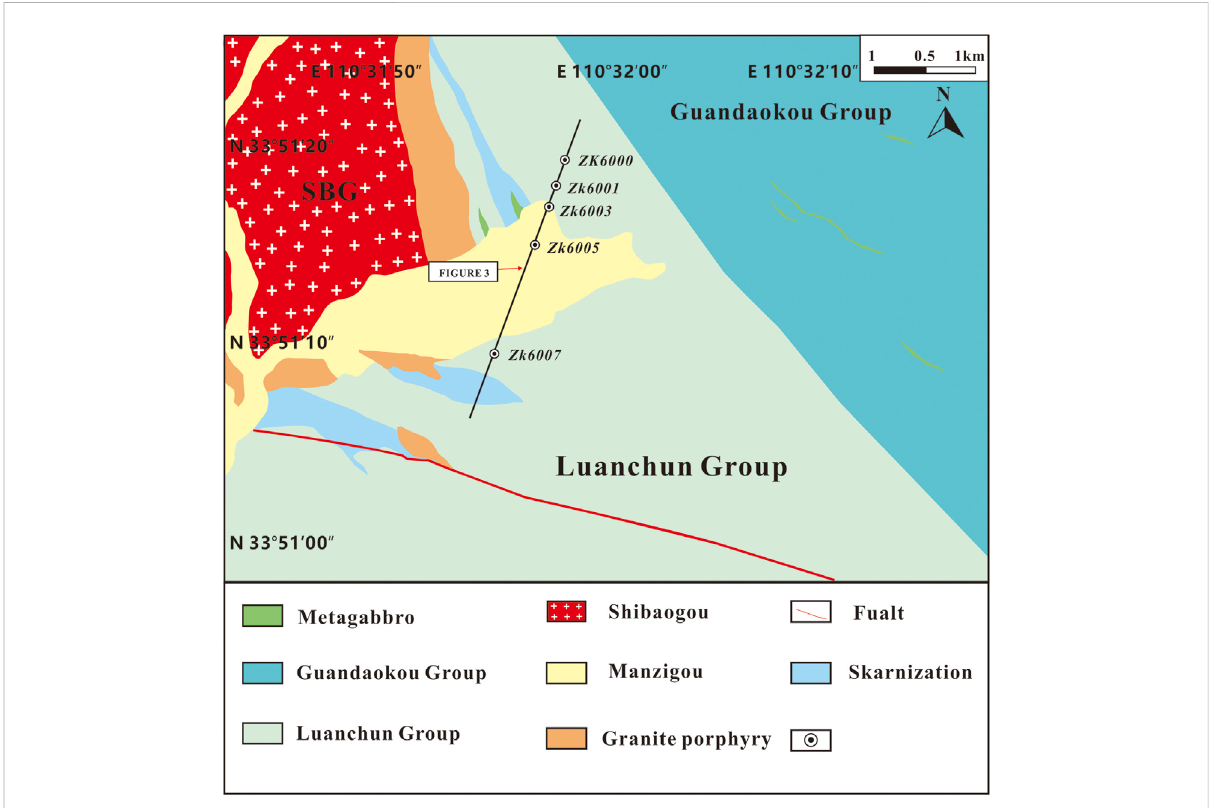
FIGURE 2 Geology of the Luanchuan ore district showing the Shibaogou Mo – Pb – Zn deposit (after Xue L. W et al.,